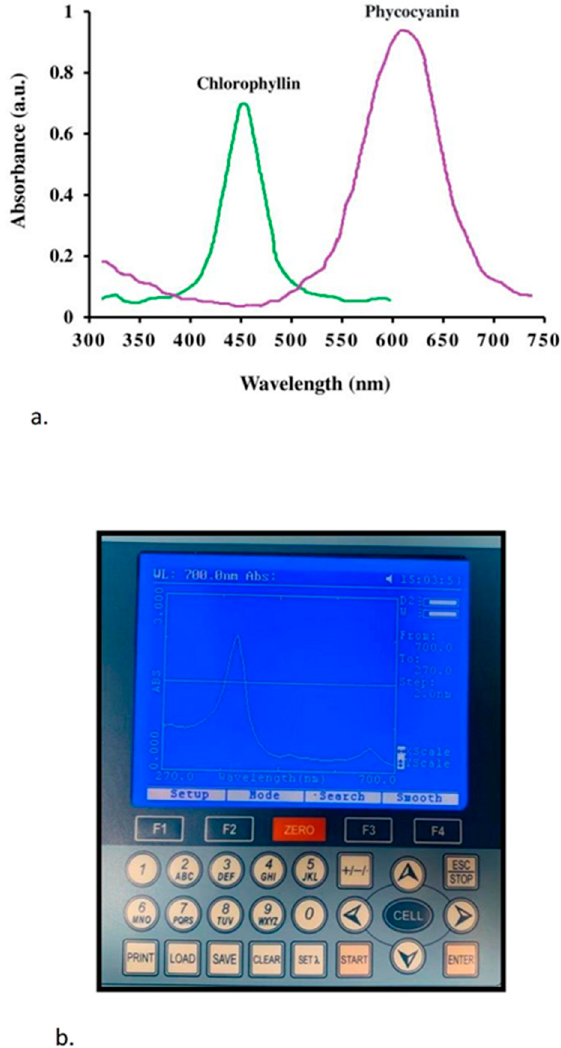
Figure 2. ( a ) Absorption curve of chlorophyllin and phycocyanin. ( b ) Absorption curve of Photoactive +